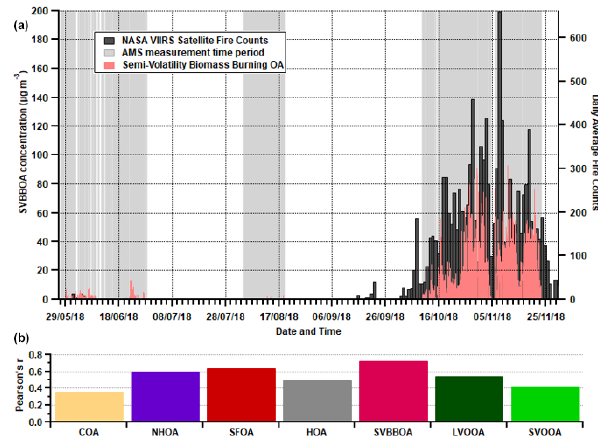
Figure 12. (a) Time series for SVBBOA along with the daily aver- age fire counts from the NASA Visible Infrared Imaging Radiome- ter Suite (VIIRS) sensor on the Suomi National Polar-orbiting Part- nership (S-NPP) satellite. (b) Pearson’s r correlations between daily average factor concentrations and the daily average fire counts. The VIIRS data cover all days displayed along the x axis, while the AMS measurements cover the grey shaded